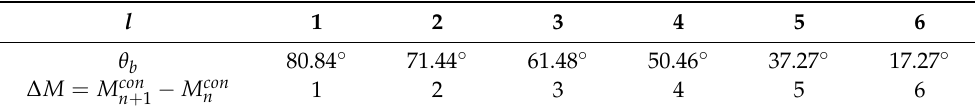
Table 1. Inter-ring number of elements variation and the corresponding base angles for uniform conical array